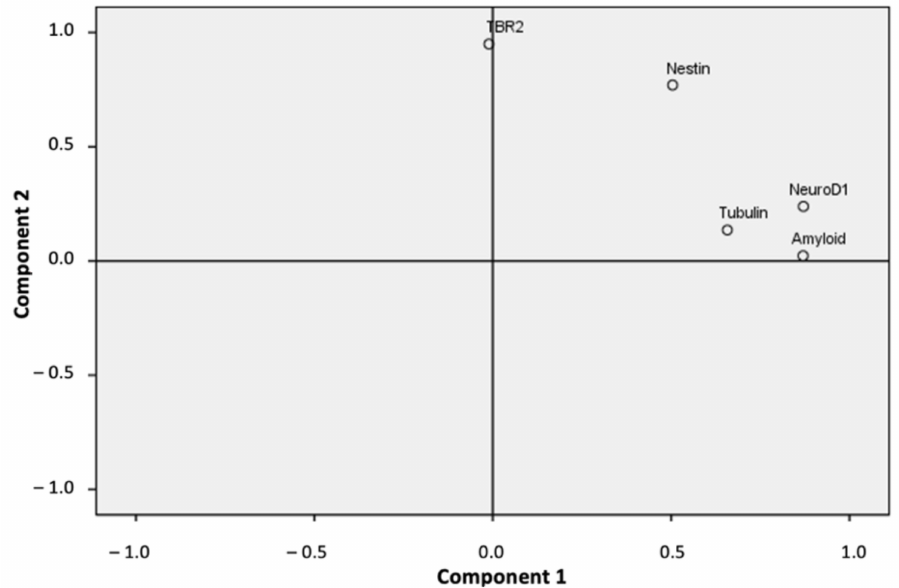
Figure 7. Dimensional representation of the PCA analysis showing the two main components found.